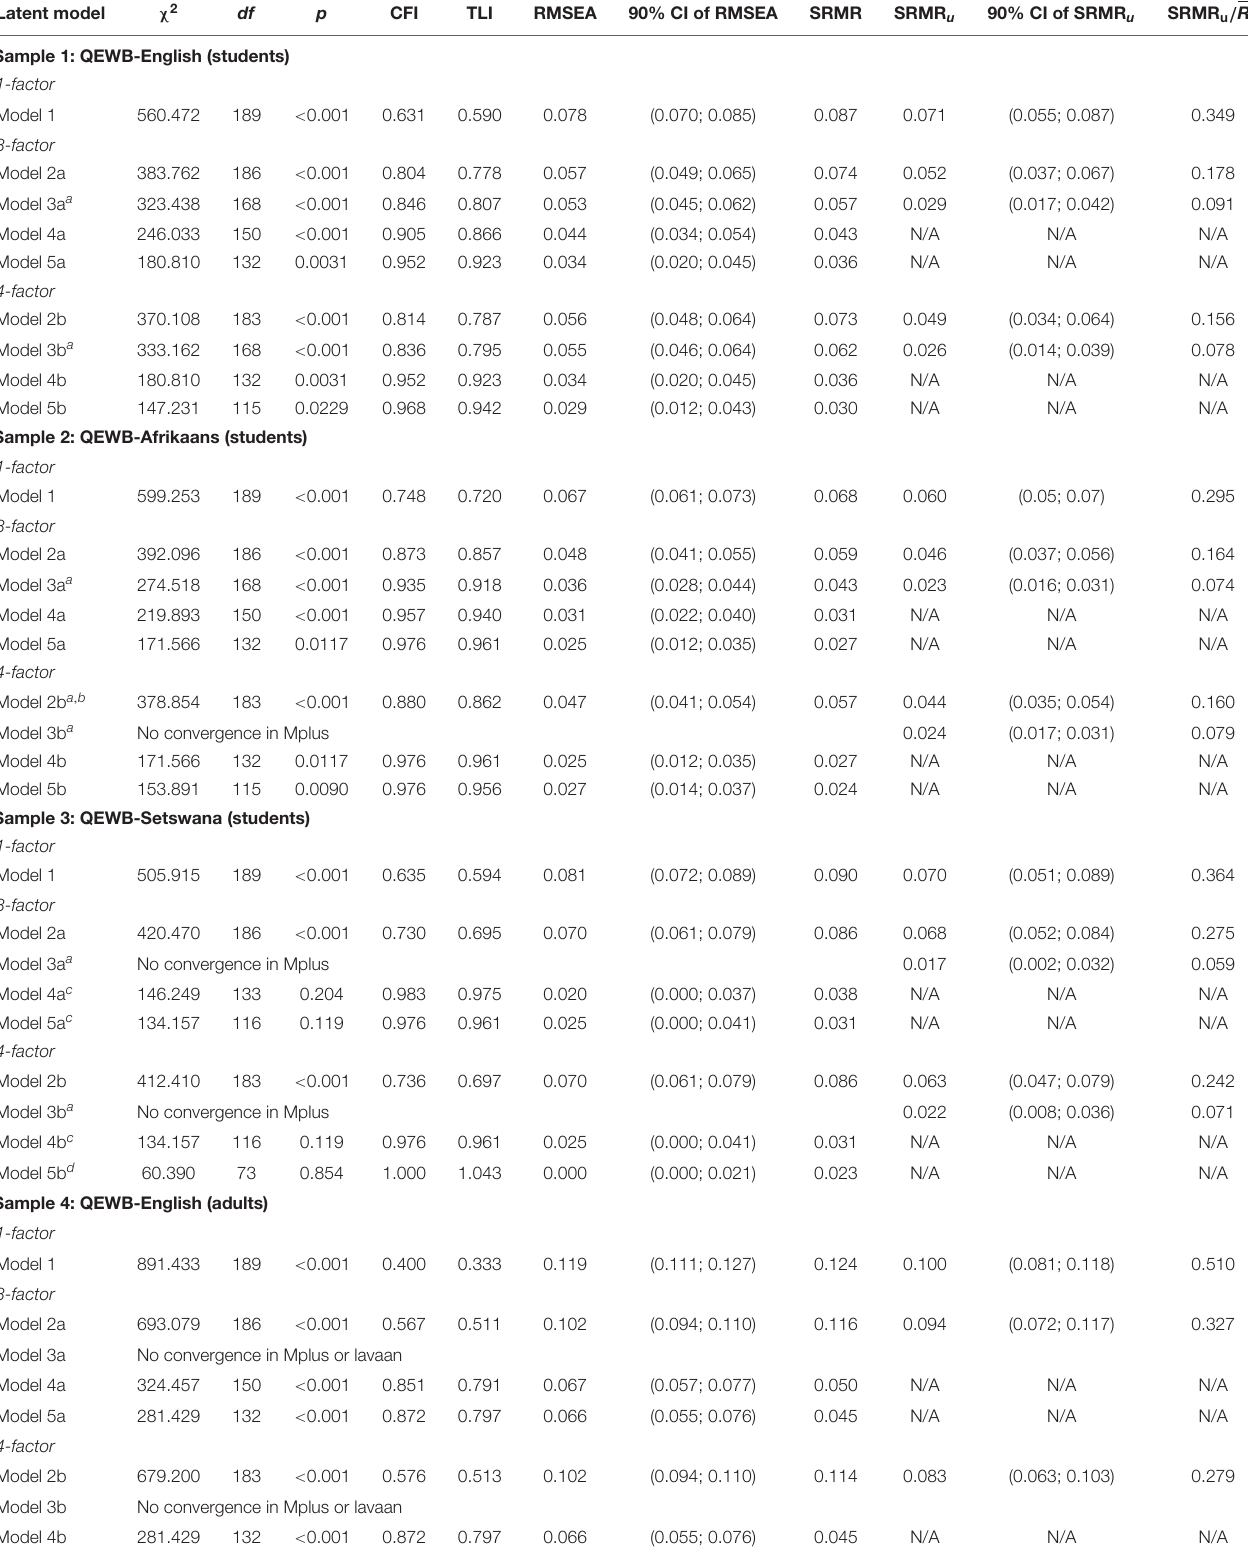
TABLE 2 | Fit indices for the one-, three-, and four-factor